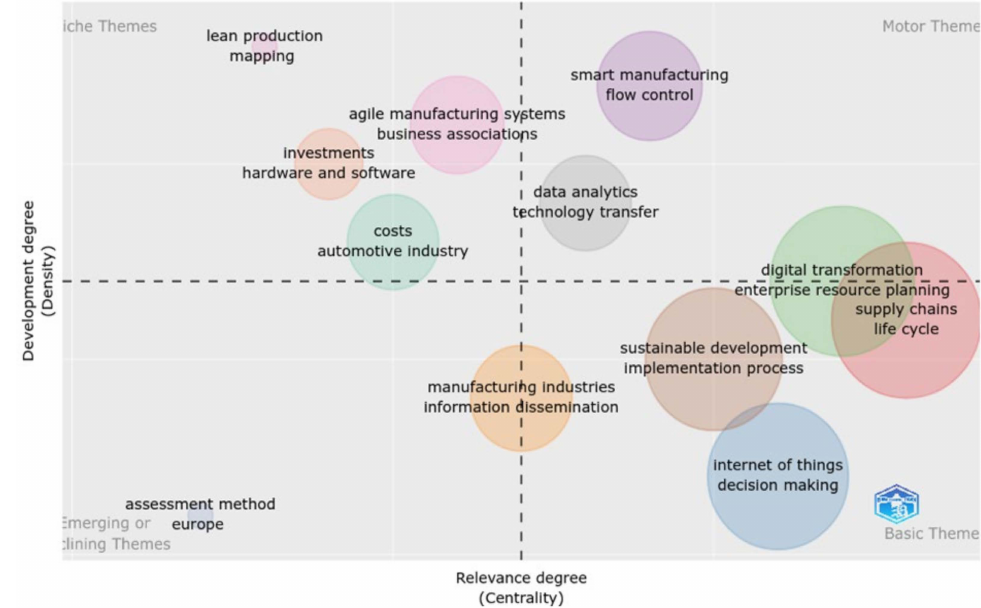
Figure 6. Pandemic period thematic evolution.